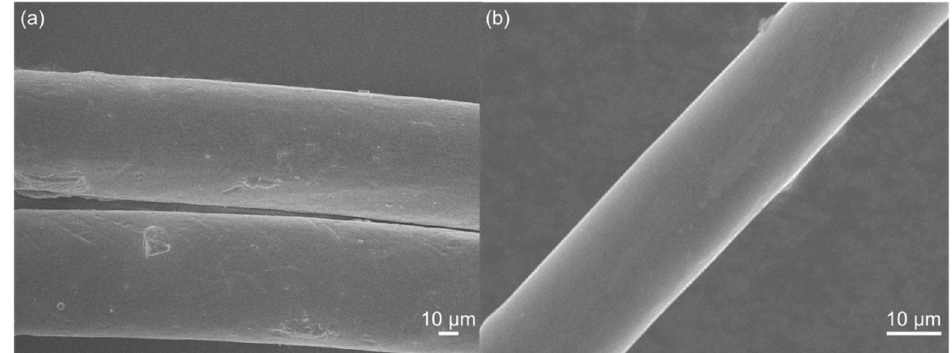
Figure 6. The scanning electron microscopy (SEM) micrographs of ( a ) CPVC spun fibre and ( b ) the CPVC-derived carbon fibre heat-treated at 1000 °C.